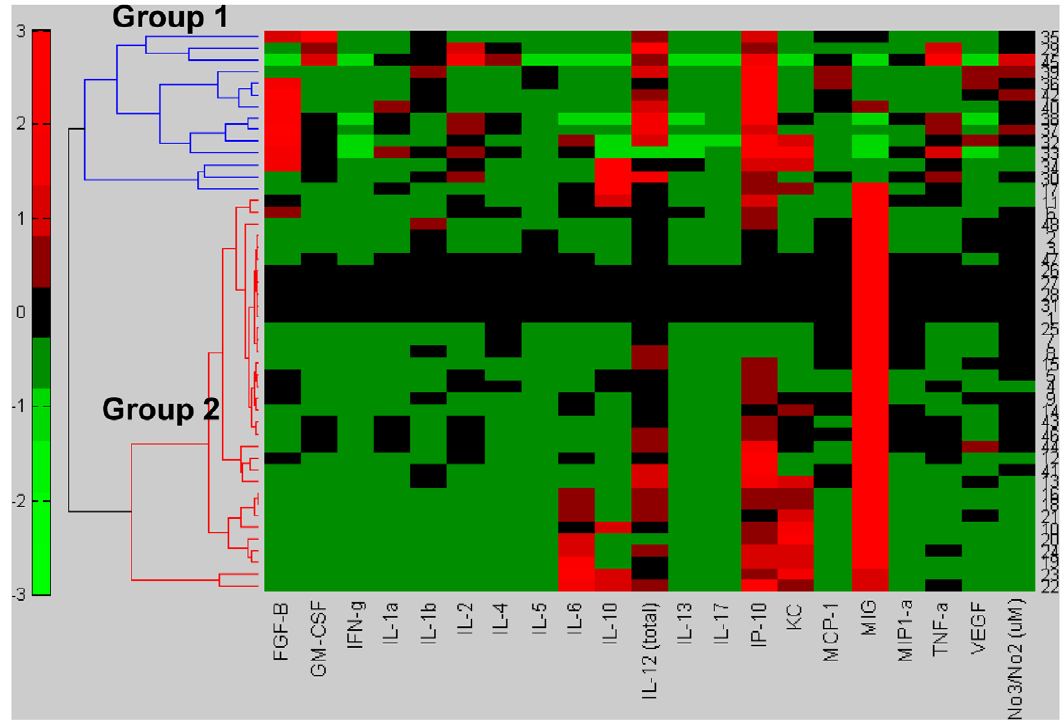
Figure 3. Hierarchical Clustering Analysis of circulating inflammation biomarkers in ST 6 HS. Mice were subjected to ST 6 HS followed by measurement of cytokines, chemokines, and NO 2 2 /NO 3 2 as described in the Materials and Methods . Group 1, depicted in blue, 93% of Group 1 samples are ST and 7% are ST + HS; in Group 2, 32% samples are ST and 68% are ST + HS. A Chi-square test with P , 0.001 suggests that the distribution of ST vs. ST + HS animals between Groups 1 and 2 is not random.